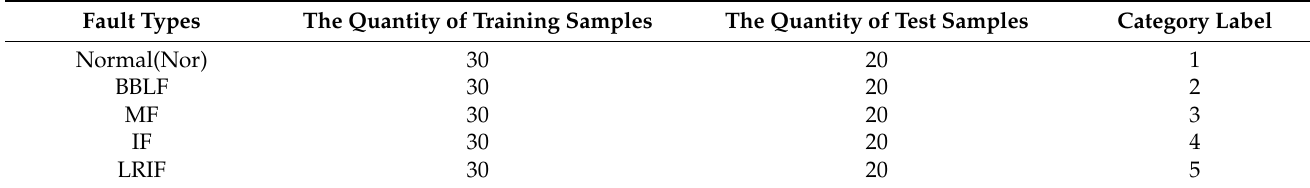
Table 4. Sample information of rotor in the experiment.